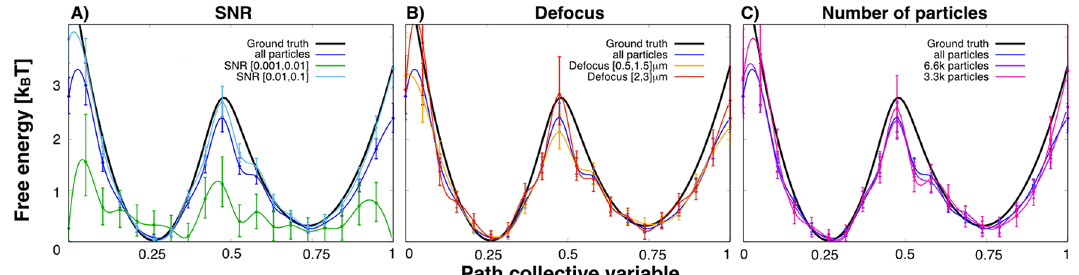
Figure 3. Free-energy profile recovery for different cryo-EM conditions. ( A ) Particles grouped by SNR from [0.01,0.1] (cyan) and from [0.001, 0.01] (green). Each subset contained around 6600 particles. ( B ) Particles grouped by defocus. Sets with small defocus [0.5, 1.5] µ m (orange) and large defocus [2, 3] µ m (red). Each subset contained around 5300 particles. ( C ) Particle subsets with a different number of particles: 3300 (pink) and 6600 (purple). For reference, the ground truth and expected free-energy profiles using all particles are shown in black and blue, respectively. The R-hat test for the MCMC yielded values < 1.01 for all cases. The bars show the credible interval at 5% and 95% of the empirical quantile at each node. The results are for the second BioEM round of orientation